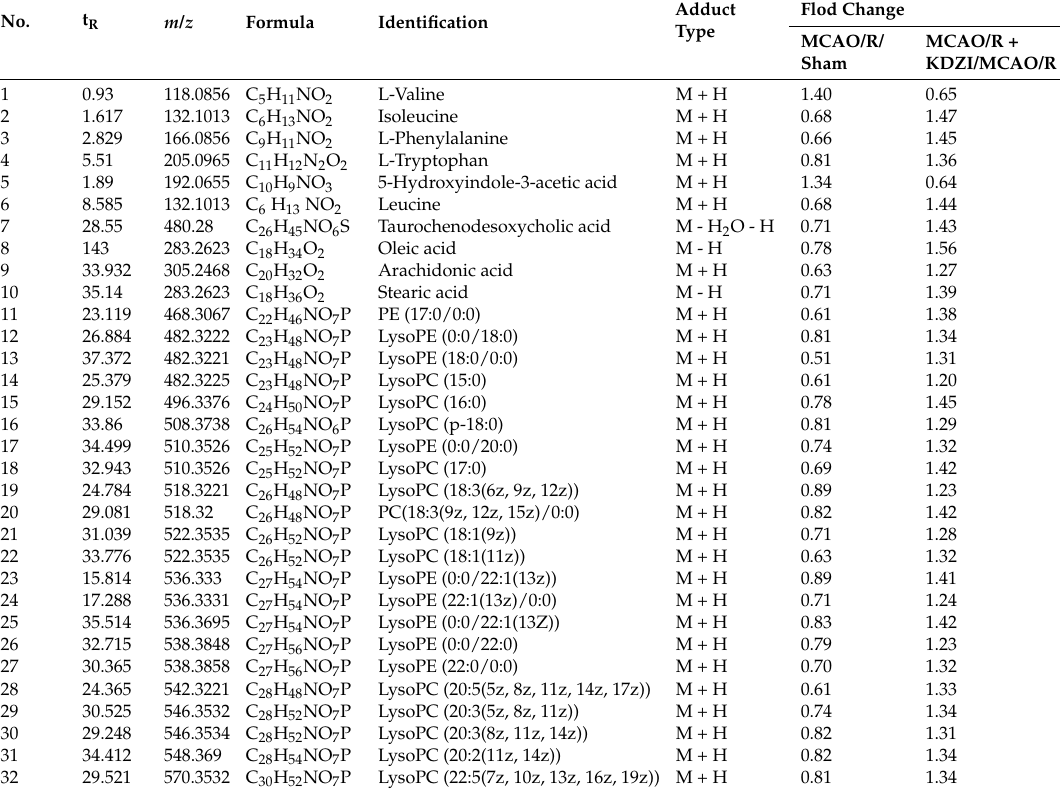
Table 2. Potential plasma biomarkers detected by LC-MS and their intensities in the sham, MCAO/R, and MCAO/R + KDZI groups analyzed by one-way